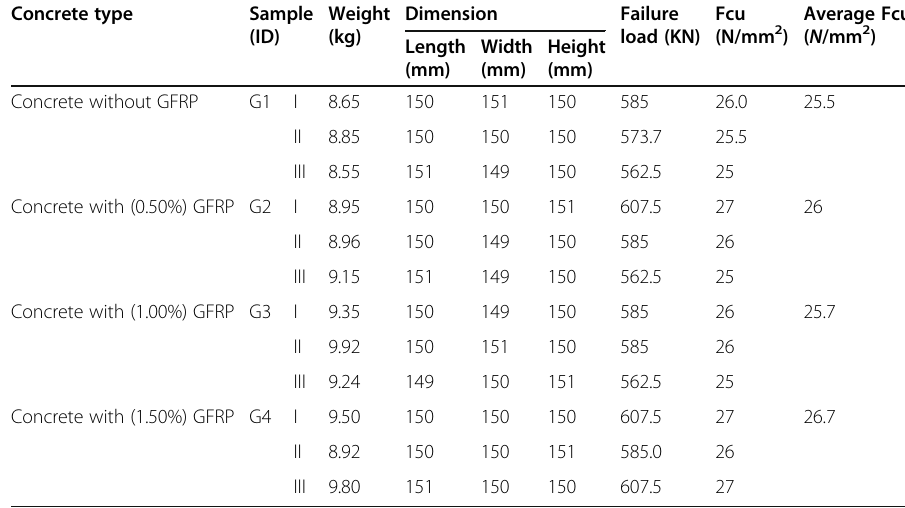
Table 2 Concrete compressive strength Concrete